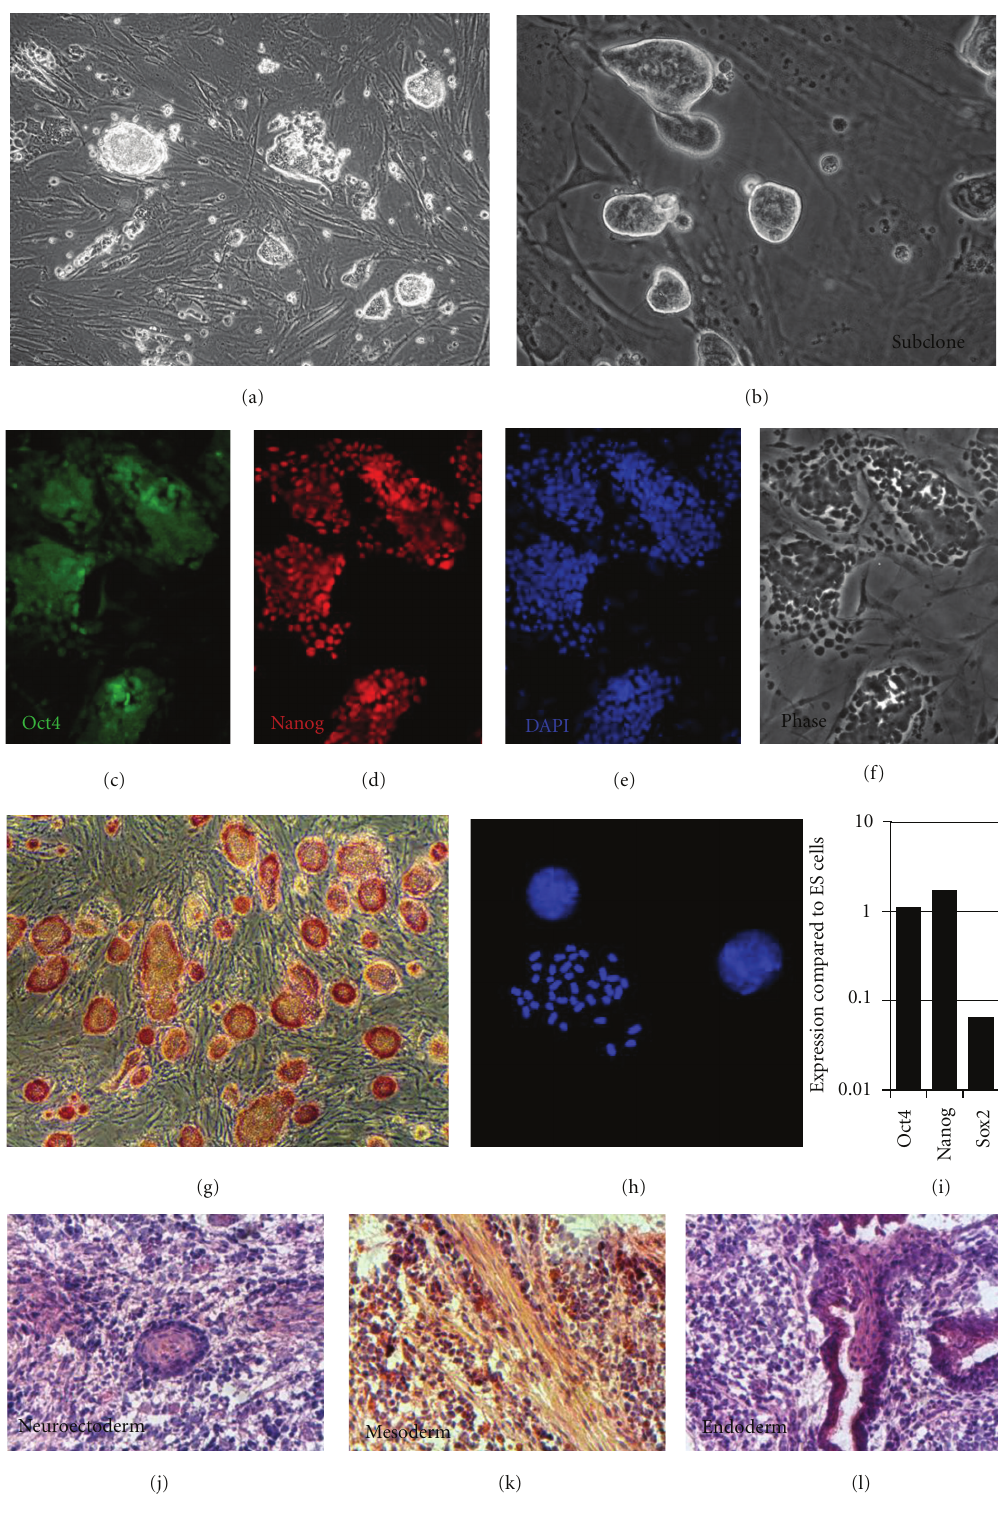
Figure 2: Generation & characterization of toxic milk iPS cells. (a) iPSCs generated from fibroblasts isolated from toxic-milk mice using retroviral vectors expressing human OCT4, KLF4, SOX2 and c-MYC. (b) iPSCs were subcloned to obtain better colony morphology. (c)–(f) Subcloned iPSCs stained positive for murine Oct4 and Nanog, whilst DAPI was used to stain the nuclei. (g) Staining for alkaline phosphatase expression of toxic-milk iPSC subclones. (h) Karyotype analysis of DAPI stained metaphase spreads. (i) qRT PCR analysis for endogenous Oct4, Nanog and Sox2 expression in toxic-milk iPSCs and OG2 ESCs compared to mouse embryonic stem cells. (j)–(l) Teratoma sections depicting formation of neuroectoderm, mesoderm (connective tissue), and